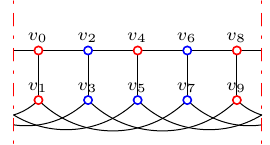
Figure 14. Segment of f in Case 2.2 in Lemma 8.